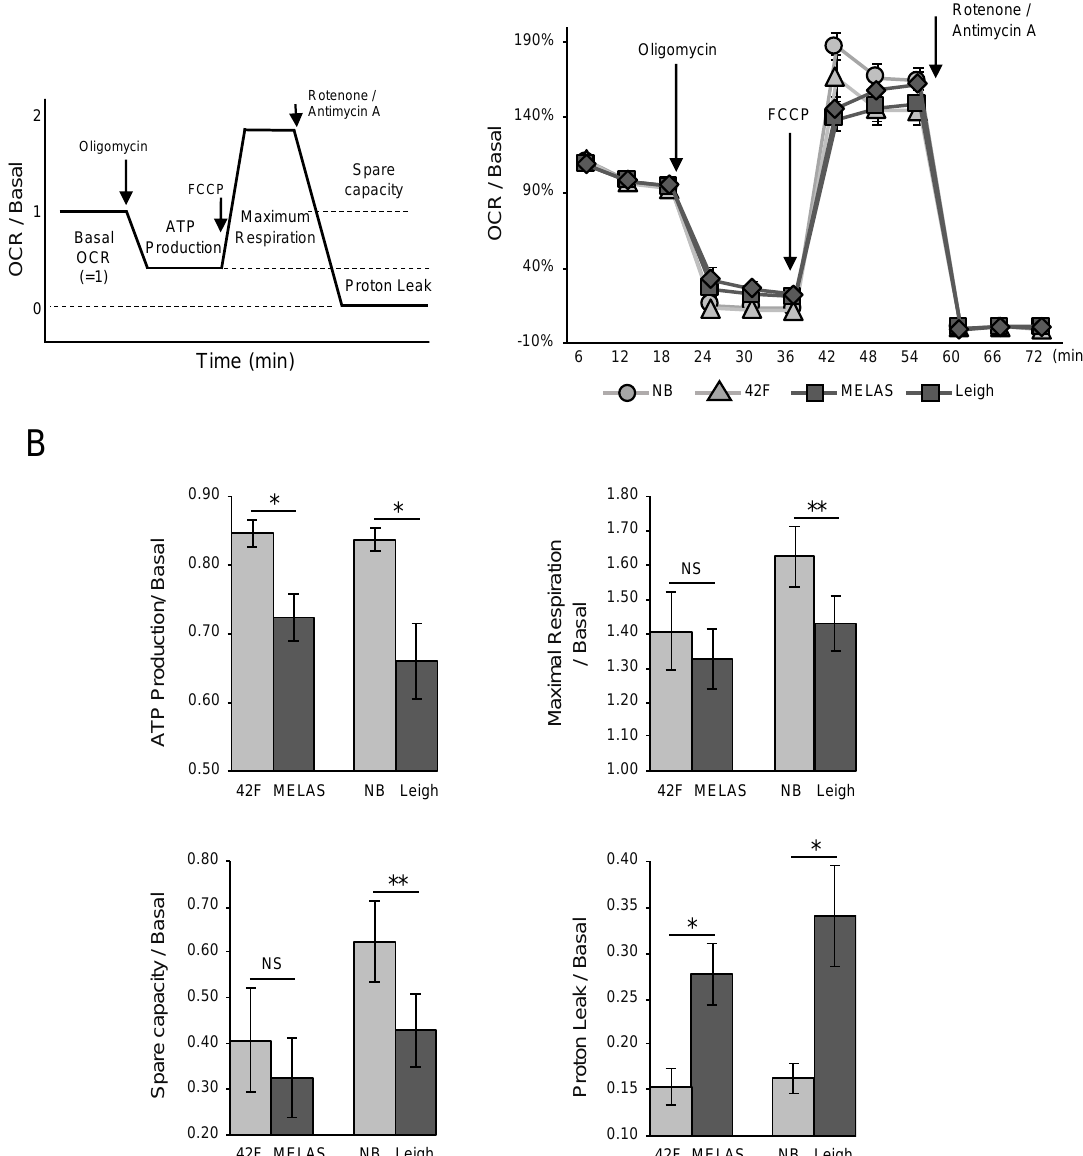
Figure 2. ( A ) Oxygen consumption rate (OCR) in healthy fibroblasts and mitochondrial disease (MD) fibroblasts. Mitochondrial respiration, reflected by OCR levels, was detected following the addition of oligomycin, carbonyl cyanide-p-trifluoromethoxyphenyl-hydrazon (FCCP), the uncoupler, or the electron transport inhibitor rotenone and antimycin A. Actual measurement values were normalized with basal respiration. The left panel shows a schematic of the experiment on OCR. ( B ) Opposite to the decrease in adenosine triphosphate (ATP)-linked OCR, proton leak increased in MD fibroblasts. Rates of ATP production, maximal respiration, spare capacity, and proton leak were quantified by normalization of basal OCR. The above data were graphed for each item. Error bars represent ± SD ( n = 4 independent experiments). * P < 0.05, ** P < 0.01 (Student’s t -test).